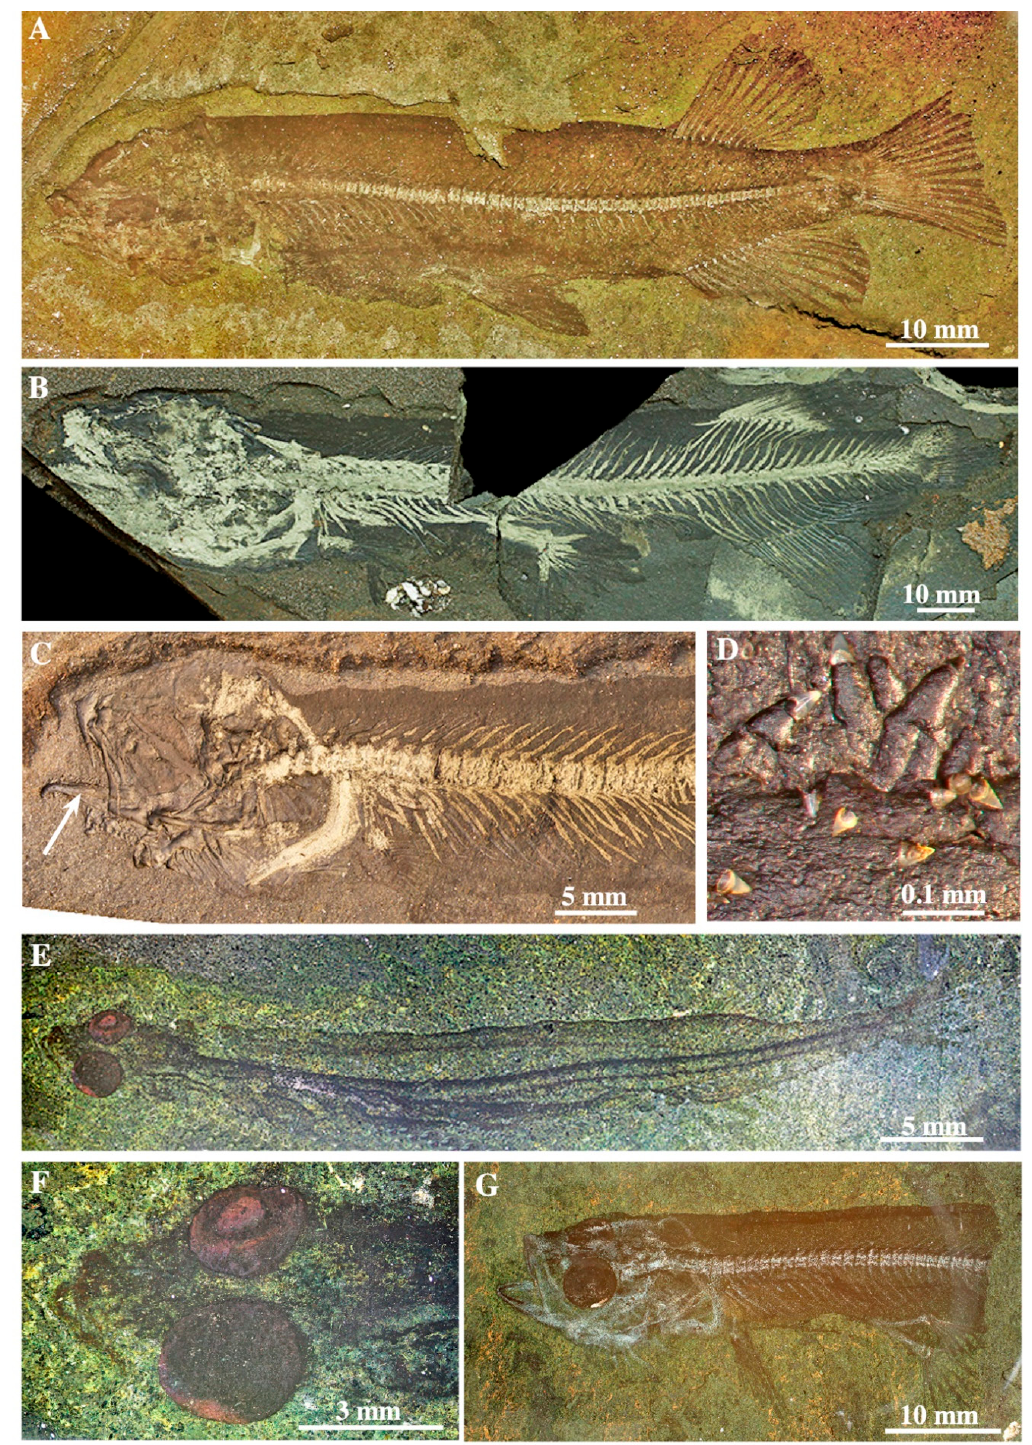
Figure 5. Hindon Maar, middle Miocene, Galaxias n. sp. ‘Hindon’. ( A ), Articulated adult with soft-tissue preservation (OU22881); ( B ), Articulated adult with soft-tissue preservation and pyritized skeleton (OU22840); ( C ), Articulated adult with partly pyritized skeleton and cranial elements (OU22872); ( D ), Close-up of C, showing stout, conical, teeth with detached acrodin caps; ( E ), Galaxias larva, fins